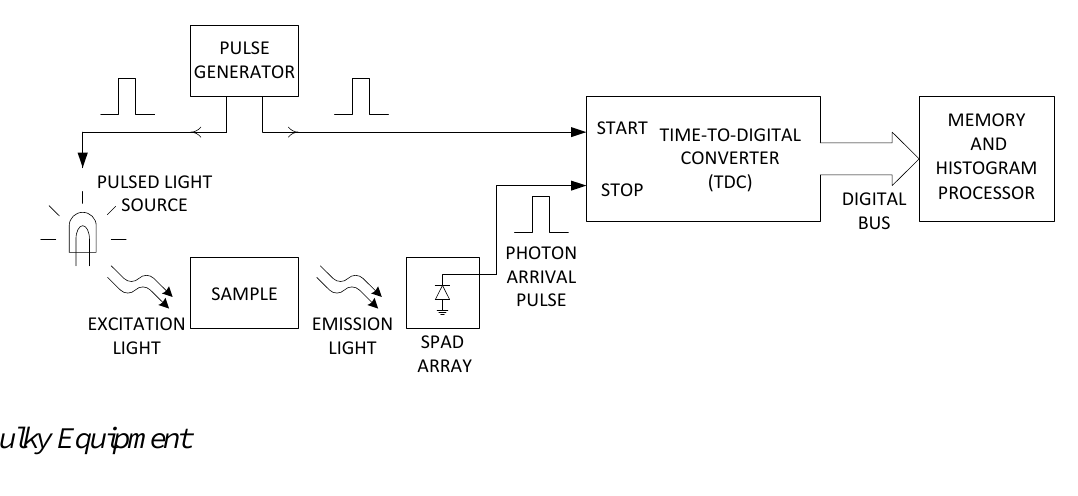
Figure 2. Time-correlated single photon counting (TCSPC) system block